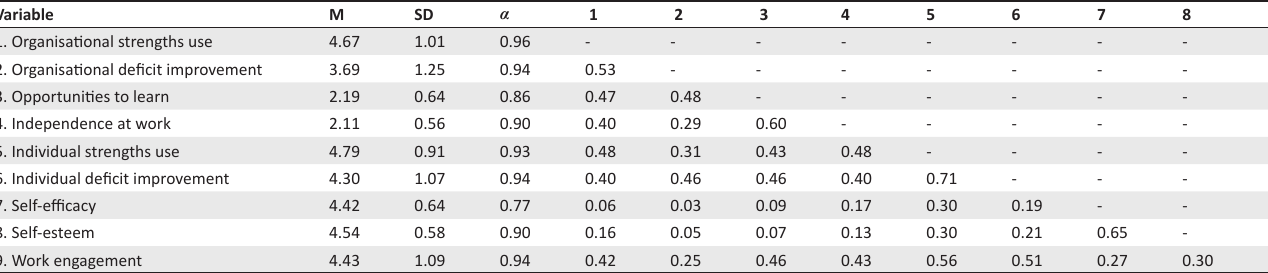
TABLE 1: Descriptive statistics and the correlation matrix ( r ) of the latent variables. Variable